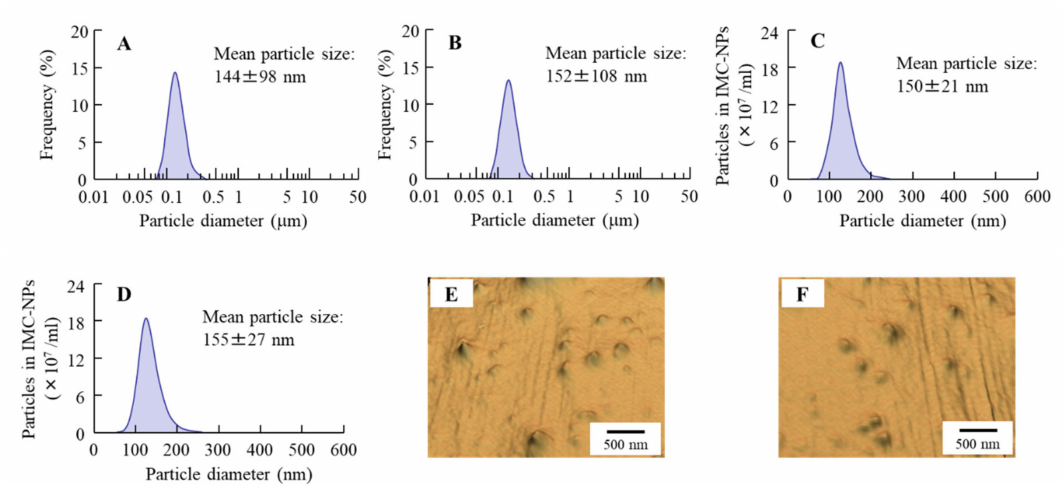
Figure 1. Size frequencies of disulfiram (DIS) particles in ophthalmic DIS formulations. A and B : Particle size of DIS nanoparticles (Dis-NPs) ( A ) and the in situ gel formulation incorporating DIS nanoparticles (Dis-NPs / ISG) ( B ) determined using the SALD-7100 laser di ff raction particle size analyzer. C and D: Particle size of the Dis-NPs ( C ) and the Dis-NPs / ISG ( D ) determined using the NanoSight dynamic light scatterer. E and F: AFM image of the Dis-NPs ( E ) and the Dis-NPs / ISG ( F ) taken using the SPM-9700. The particle size of DIS in the Dis-NPs and the Dis-NPs / ISG was approximately 80–250 nm.